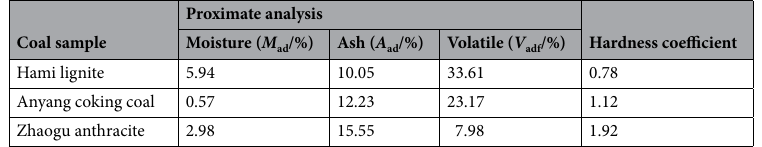
Table 1. Proximate analysis and firmness coefficient of the coal samples.